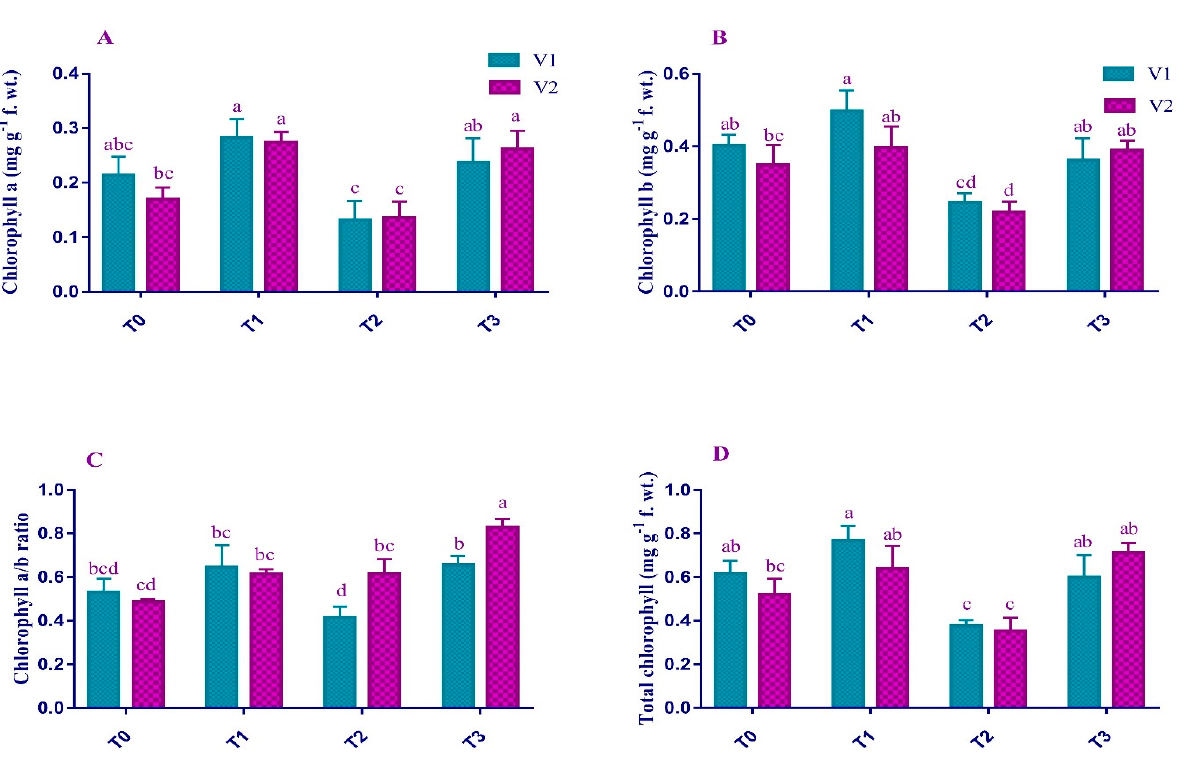
Figure 2. Effect of Pb and EDTA on ( A ) chlorophyll a (mg g − 1 f. wt.), ( B ) chlorophyll b (mg g − 1 f. wt.), ( C ) chlorophyll a / b ratio and ( D ) total chlorophyll (mg g − 1 f. wt.) of brown mustard. Error bars above means indicate the ± SE of three replicates. Means sharing a letter for a parameter do not differ significantly at p ≤ 0.05. V1 = Faisal cultivar; V2 = Rohi cultivar; T 0 = 0 mM EDTA + 0 mM Lead acetate; T 1 = 2.5 mM EDTA + 0 mM Lead acetate; T 2 = 0 mM EDTA + 0.5 mM Lead acetate; T 3 = 2.5 mM EDTA + 0.5 mM Lead acetate.